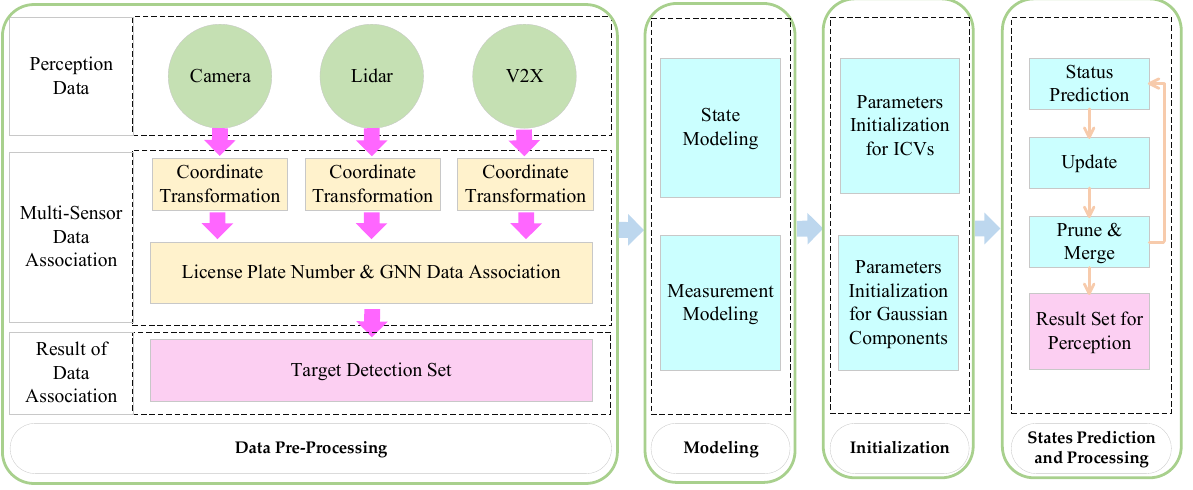
Figure 2. Processing of vehicle perception based on GM-PHD model.